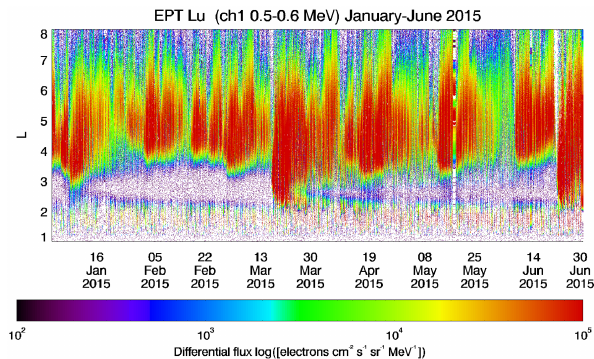
Figure 9. Electron fluxes observed by EPT/PROBA-V in Channel 1 (500–600keV) as a function of L between 1 January and 30 June